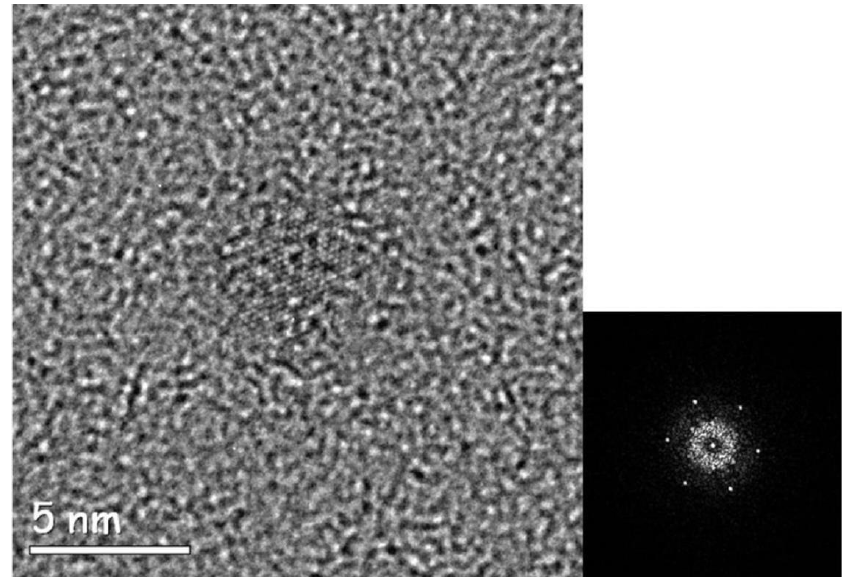
Figure 5. Left: Low dose rate HRTEM of a particle of vincamine. Right: The relevant high symmetry diffractogram (reprinted by courtesy from Hasa et al. [4]).